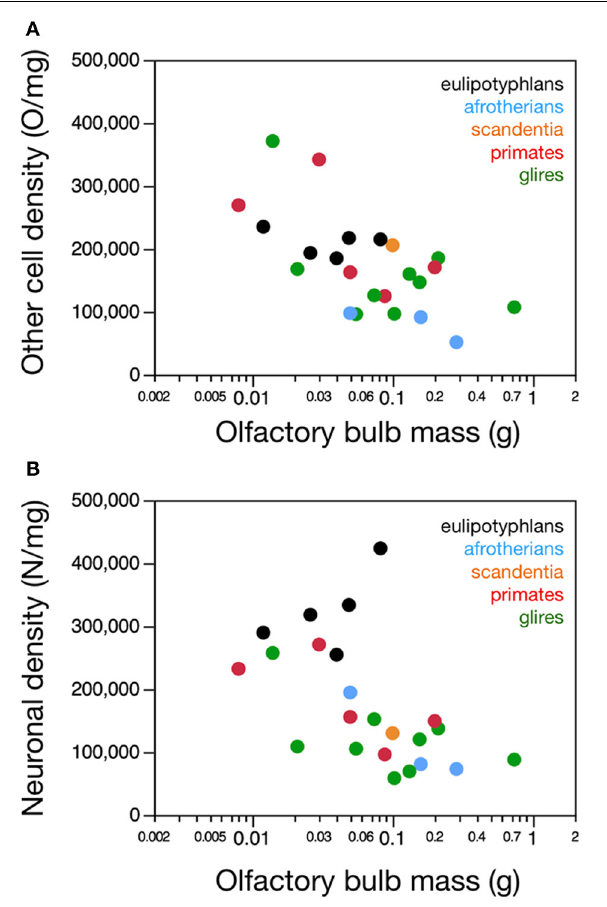
FIGURE 3 | Neuronal and non-neuronal cell densities in the olfactory bulb. Graphs show the relationship between olfactory bulb mass and (A) average non-neuronal (other) cell density or (B) average neuronal density in the olfactory bulb across species. (A) There is no significant correlation between other cell density (in other cells/mg) and olfactory bulb mass across species within any order. (B) Neuronal cell density does not correlate with olfactory bulb mass in primates (and scandentia) or glires, but it does increase with larger olfactory bulb mass in eulipotyphlans when the outlier, the star-nosed mole, is excluded. Notice that neuronal densities in the olfactory bulb in eulipotyphlan species are higher than in most other species. Eulipotyphlan data from Sarko et al. (2009). Afrotherian data from Neves et al. (2014). Glires, data from Herculano-Houzel et al. (2011) and this study. Primates and scandentia, data from this